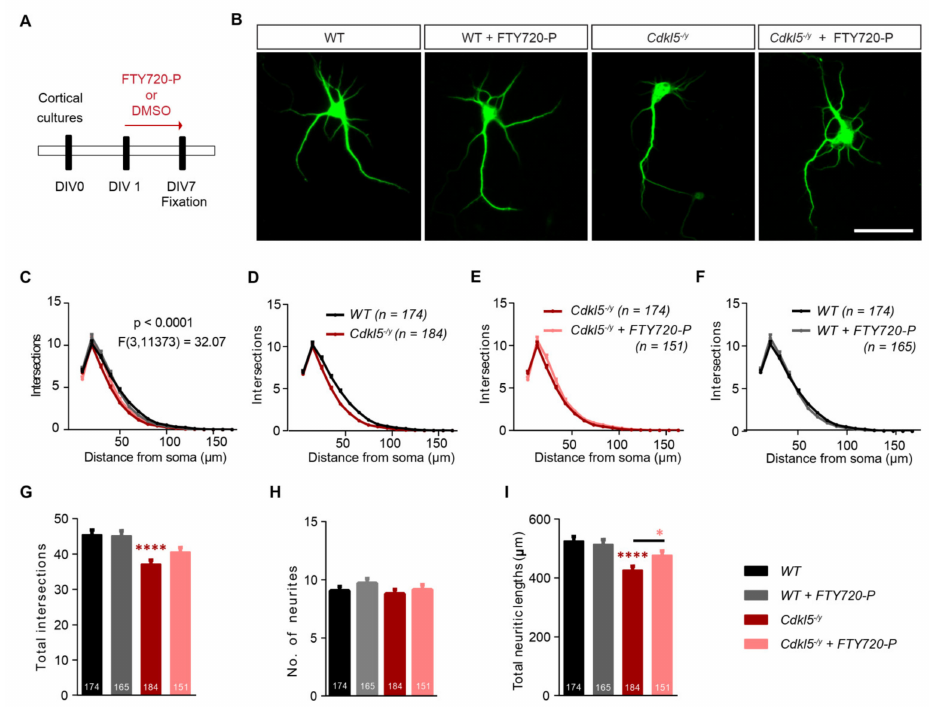
Figure 5. Fingolimod-phosphate (FTY720-P) shows mild rescue in neuronal morphology of young cortical neurons from Cdkl5 - / y mice. Young DIV7 cortical cultures from mice carrying a Cdkl5 - / y mutation or littermate wild type (WT) controls, were grown in presence of DMSO alone or 10 nM FTY720-P